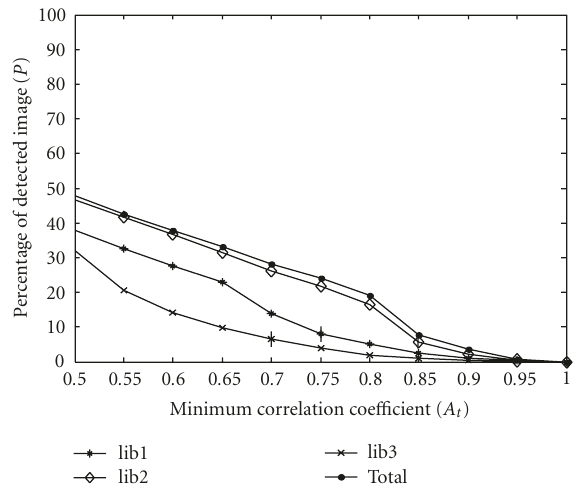
Figure 4: Relationship between the correlation value used and de- tected image percentage of detected image ( P ). Thirty one bands of input image data are used in the simulation.